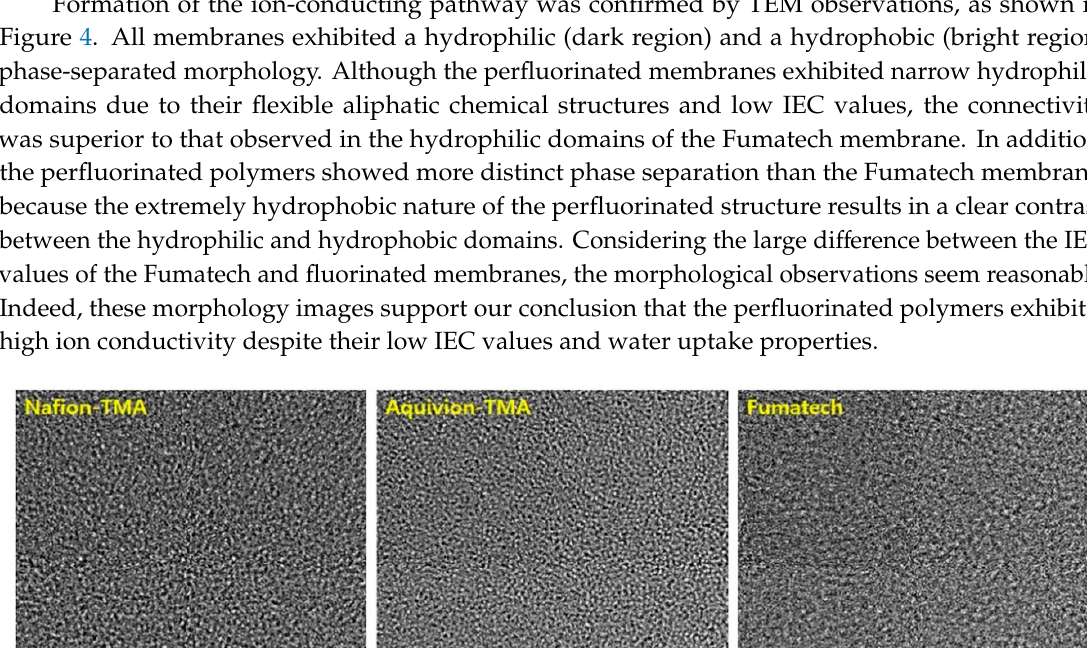
Figure 3. Ion conductivities of the Nafion-TMA, Aquivion-TMA, and Fumatech membranes at different relative humidities.